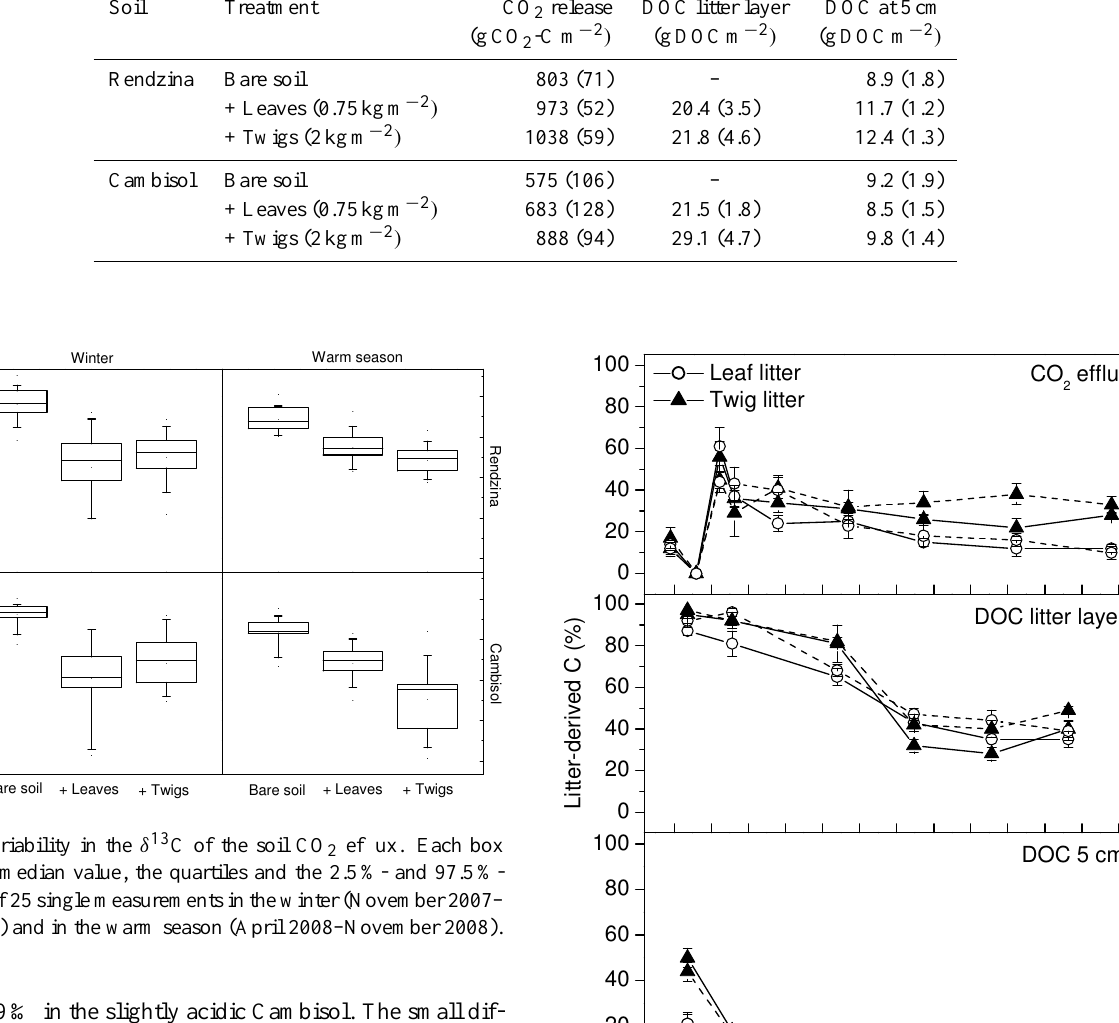
effluxes and to the DOC leached from 2 2